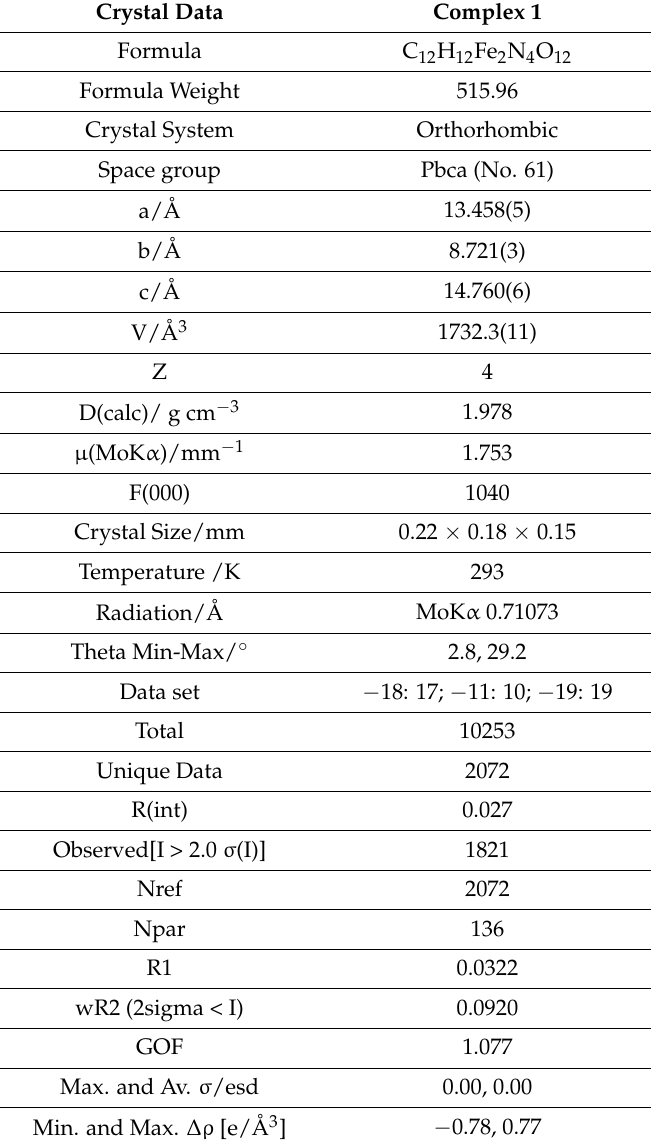
Table 1. Crystal Data for the Structure Determination of {[Fe(3,6 pzdc)](H 2 O) 2 } 2